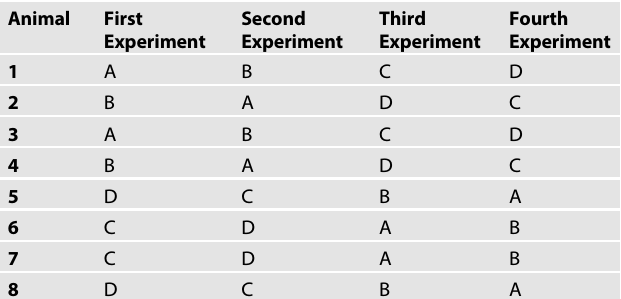
Table 1. Counterbalancing of treatment